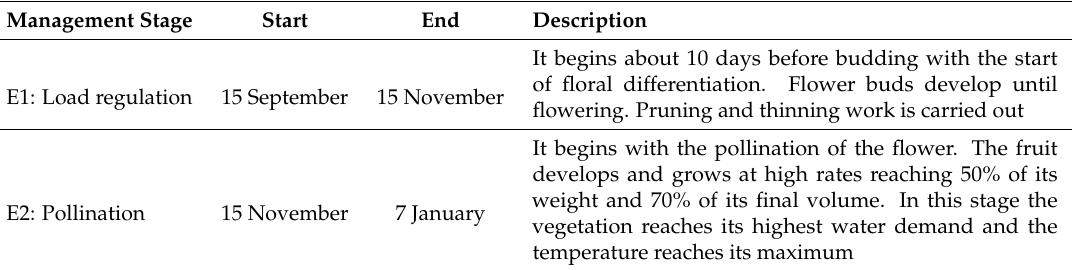
Table 1. Description and approximate start dates of the main stages of agricultural management